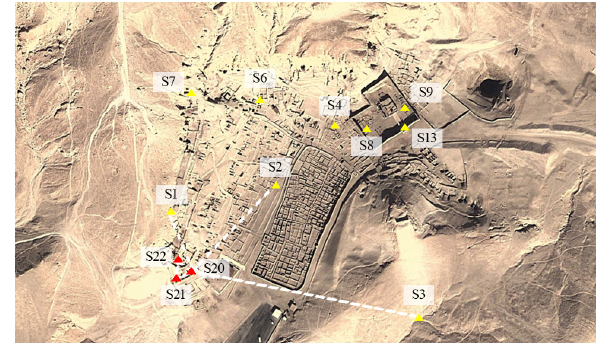
Figure 4 . Topographic